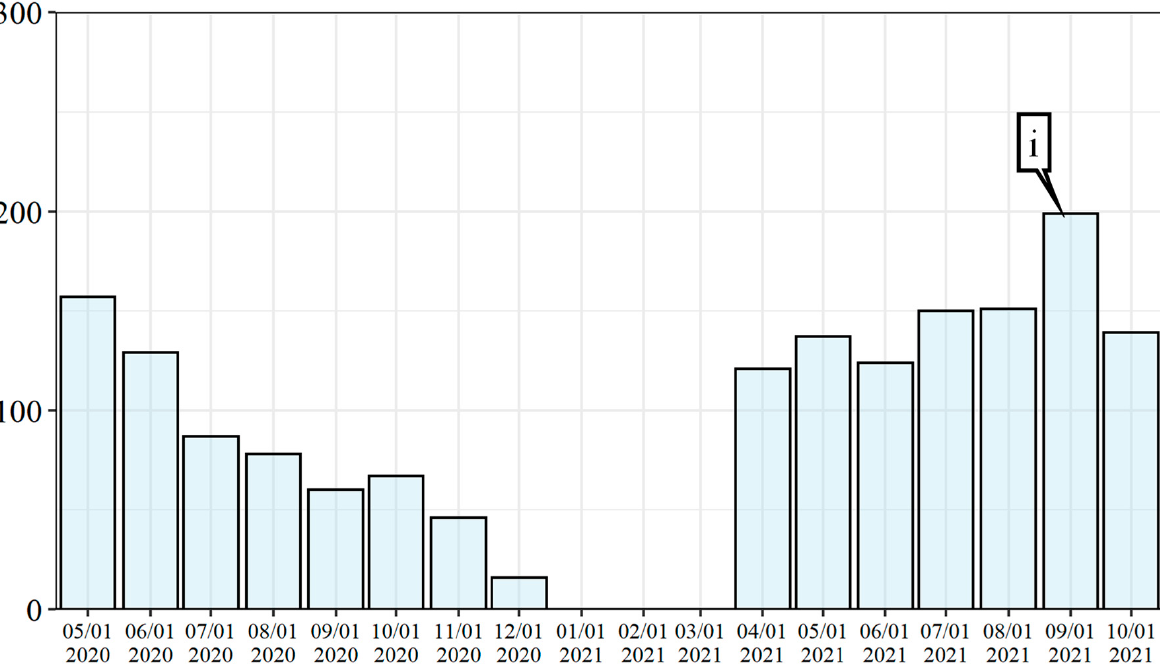
Figure 19. Monthly hard-braking events along I-70 EB from MM 65 to MM 66.8.